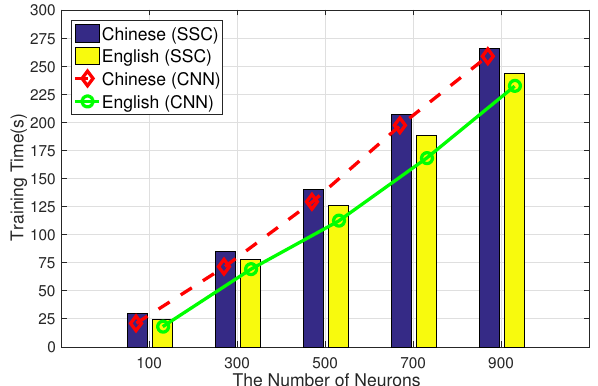
Figure 12. The training time on different numbers of neurons.